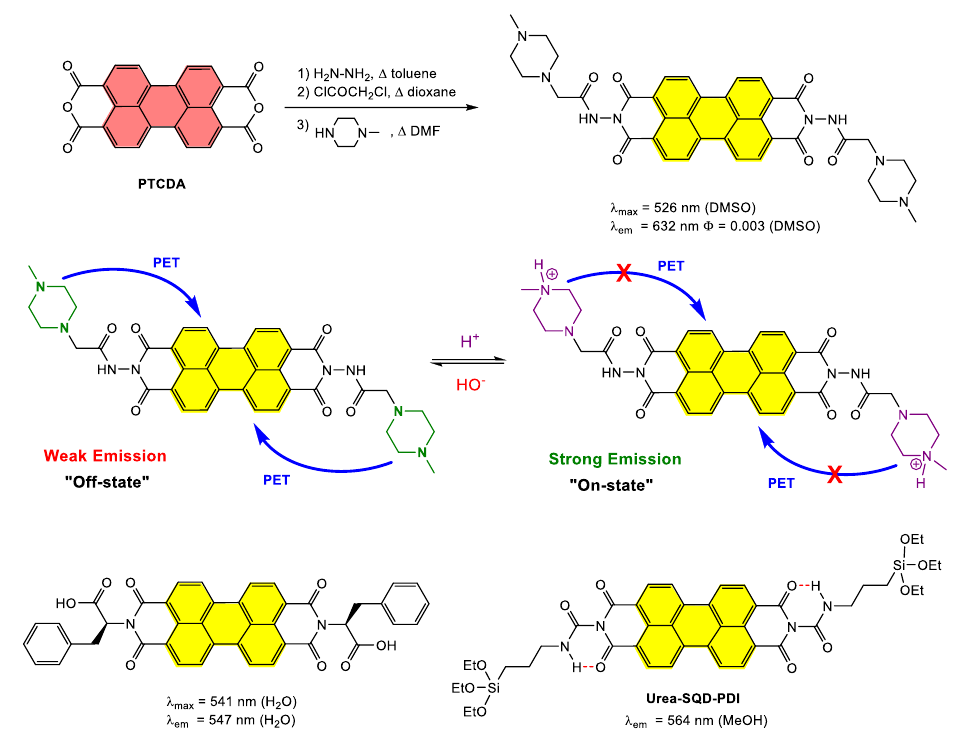
Scheme 6. Synthesis of PDI substituted with two N-methylpiperazine groups in imide positions and pH-dependent photophysical behaviour of the probe; structures of PDI derivatives substituted in imide positions with two L-phenylalanine or N-propylurea